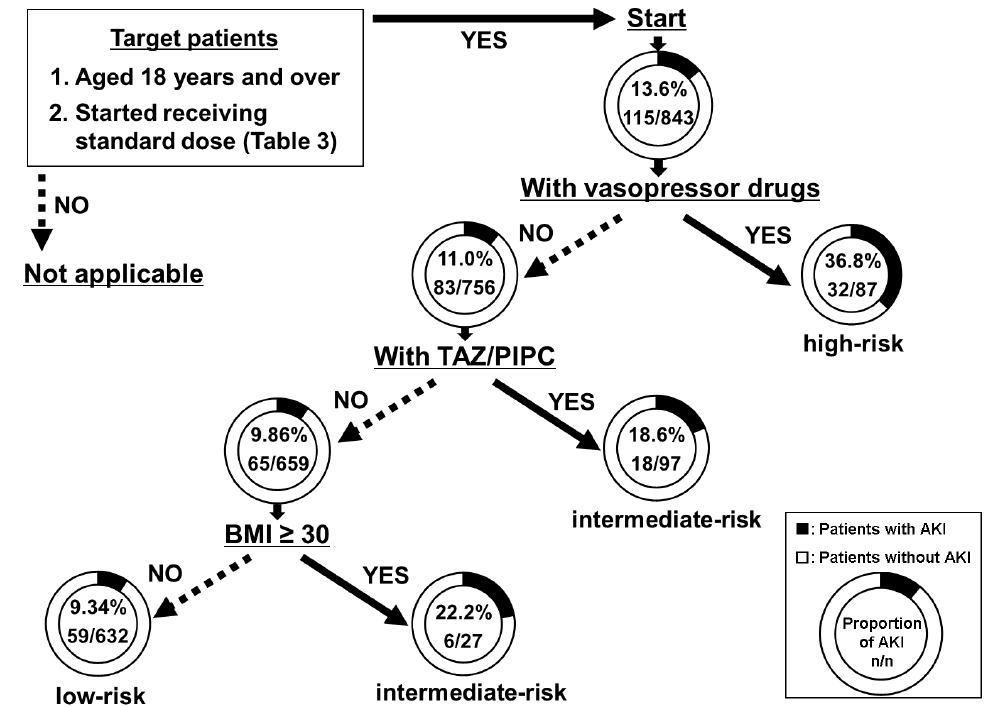
Figure 2. Flowchart for the risk prediction of VCM-induced AKI. A flowchart was proposed for predicting the risk of VCM-induced AKI at the time of administering the standard dose when initiating VCM therapy. Target patients are “aged 18 years and over” and “started standard dose of VCM”. Subgroups of the flowchart were categorized by the proportion of VCM-induced AKI as follows: ( 1 ) low-risk group (<10%), ( 2 ) intermediate-risk group (10–25%), and ( 3 ) high-risk group (>25%).